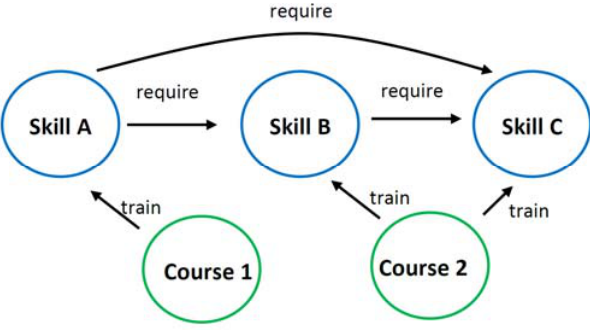
Figure 2. Transitivity of skills and their relation to disciplines (an example).